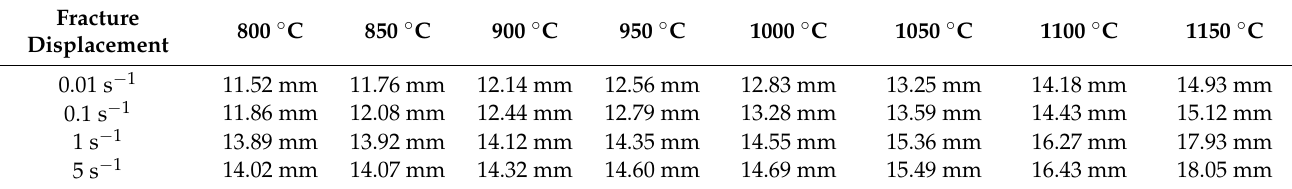
Figure 3. Cr5 steel displacement–load curves with different temperatures and different strain rates: ( a ) 𝜀(cid:4662) = 0.01 s − 1 ; ( b ) 𝜀(cid:4662) = 0.1 s − 1 ; ( c ) 𝜀(cid:4662) = 1 s − 1 ; ( d ) 𝜀(cid:4662) = 5 s − 1 . Table 2. Fracture displacement of Cr5 alloy steel under different deformation